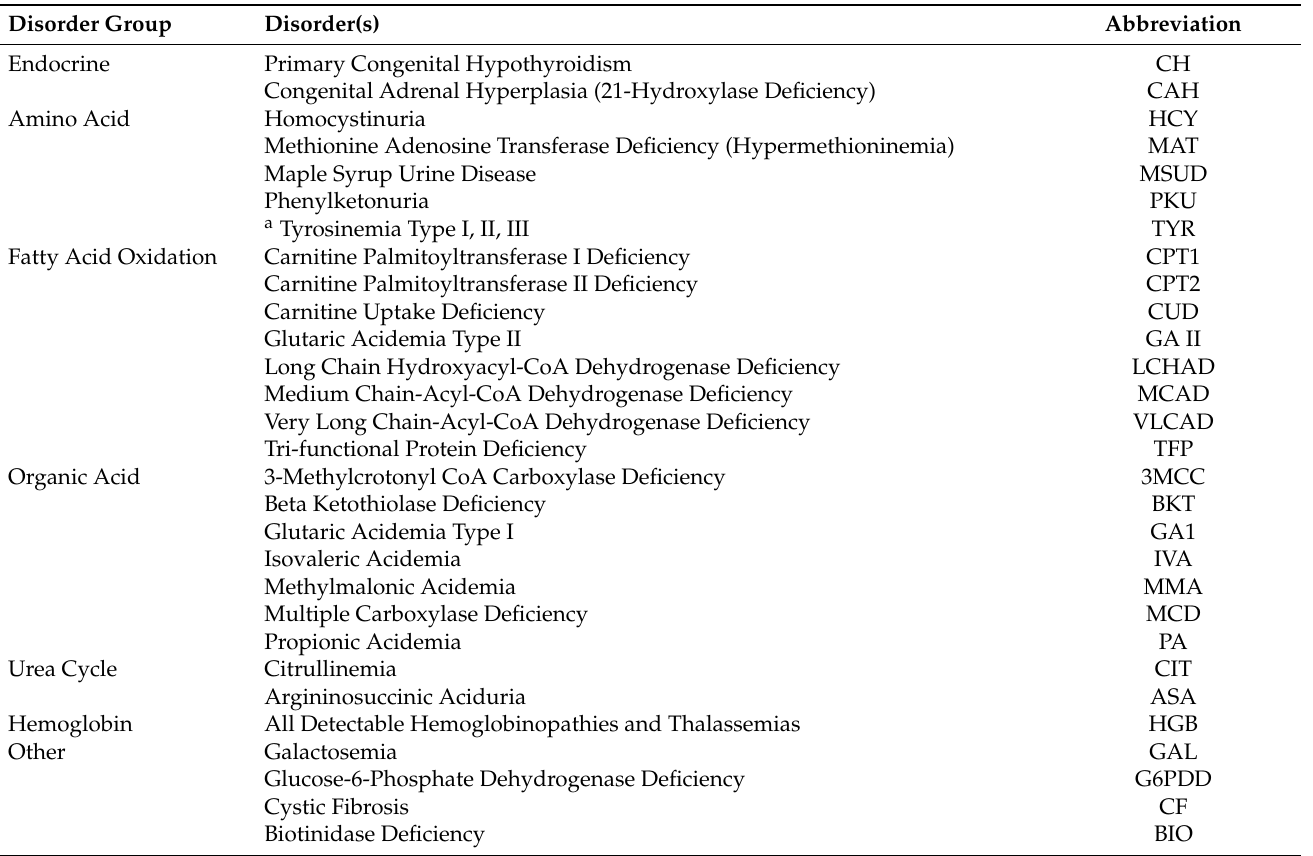
Table 1. Disorders included in the Philippine Expanded Newborn Screening